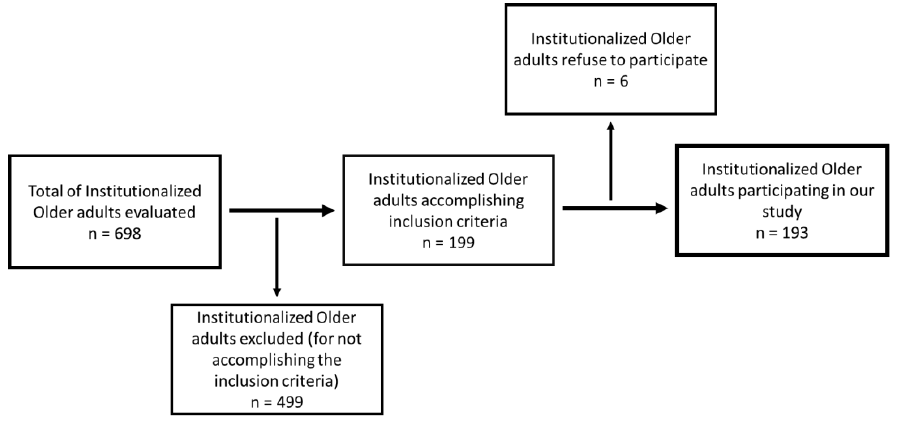
Figure 1. Participant inclusion flowchart.